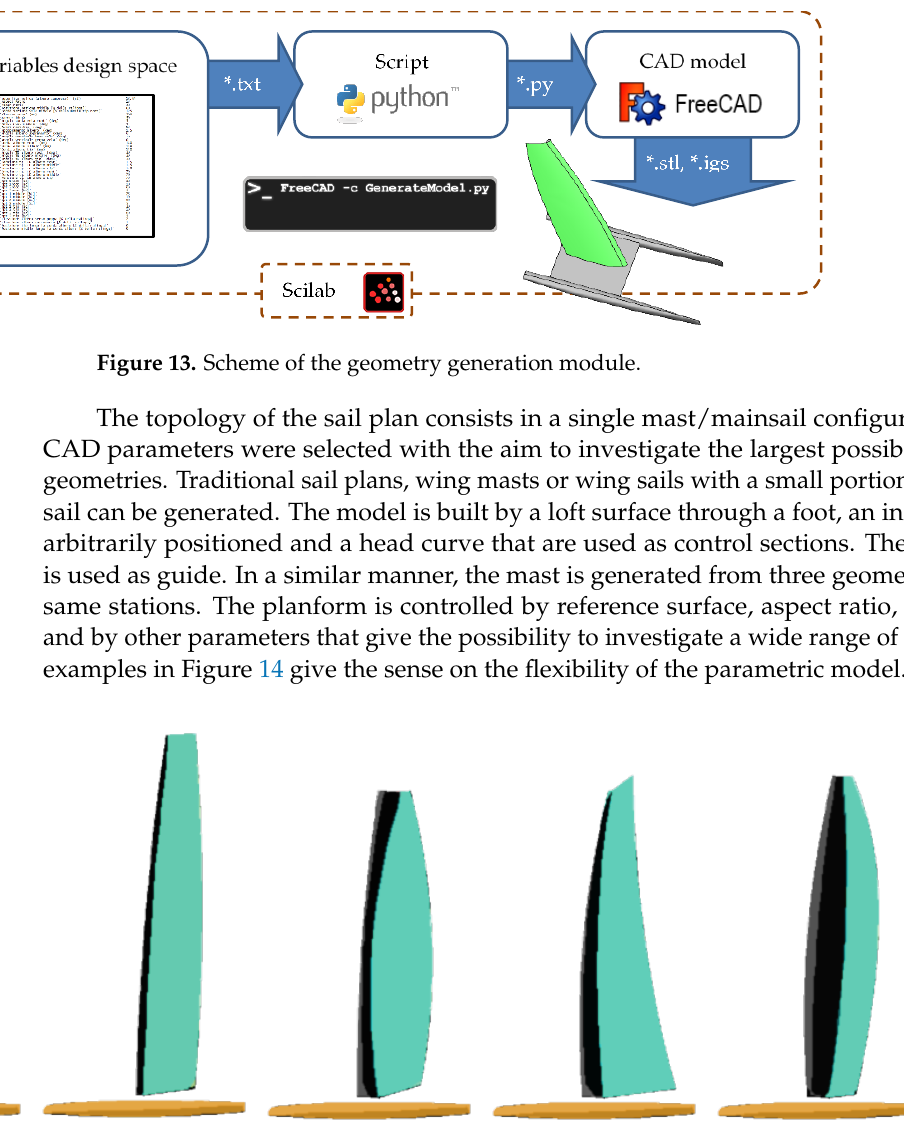
Figure 14. Examples of sail planforms that can be generated by the parametric CAD module. The sail sections are generated by cubic Bezier curves. The first point of the control polygon is connected to the mast luff, the last one coincides with the leech of the sail. The four coordinates of the two intermediate control points are parameters of the geometry (red polylines in Figure 15). The mast sections are generated by spline curves controlled by three parameters. The spanner angle (angle between the mast chord and the boat symmetry plane) is a setting parameter. The input reference surface area is kept unchanged. After the geometry creation, the final sail area is measured and the loft surface cut in order to restore the required value. The procedure is linked to the sail CFD analysis module. Two versions of the fluid dynamic computation were setup: one based on commercial software and one based on an Open-Source